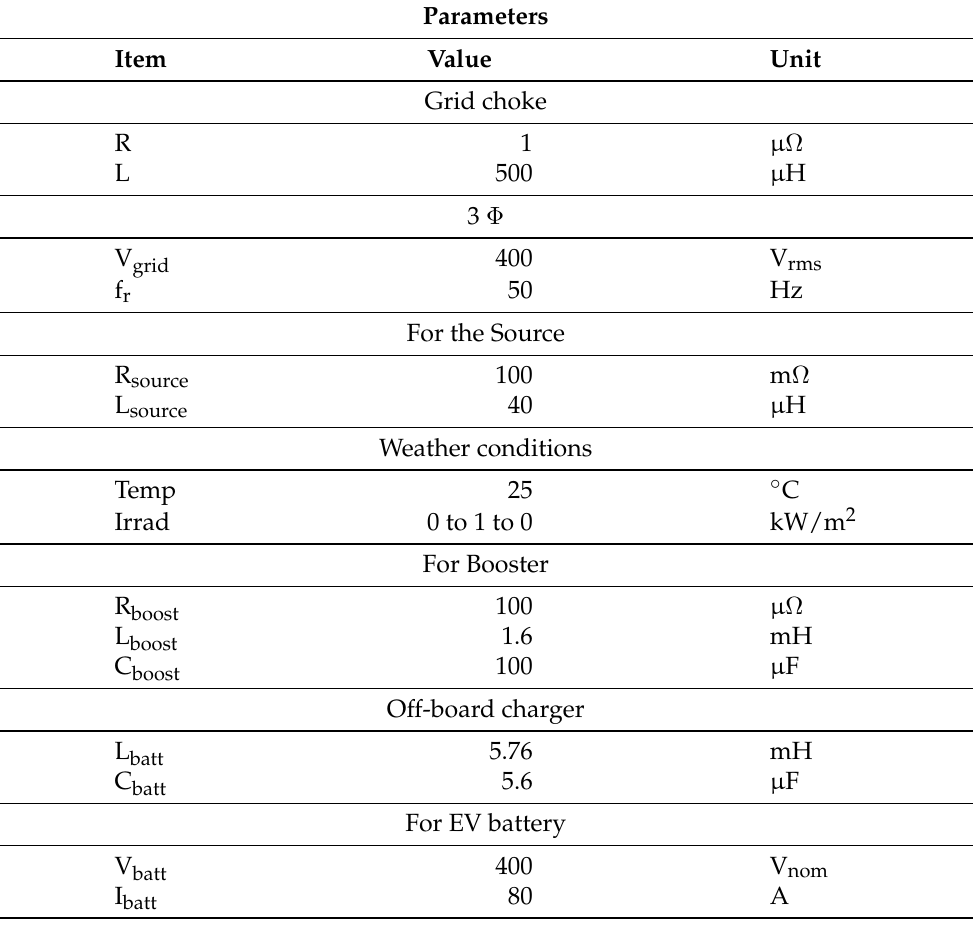
Table 1. The Simulink model parameters.